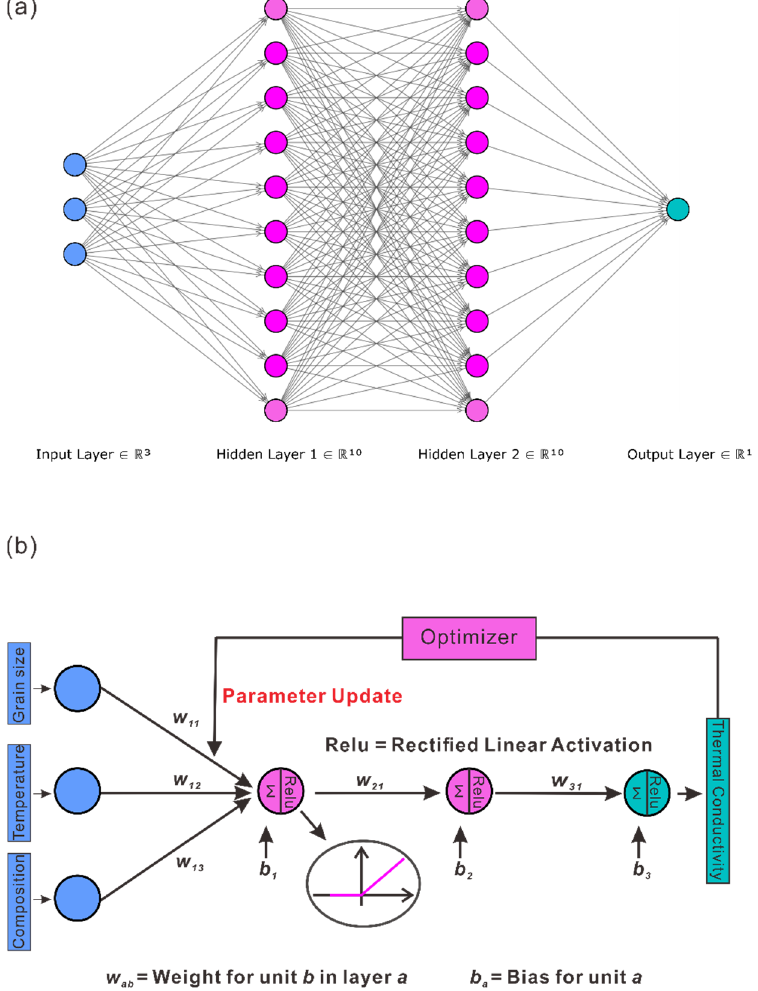
Figure 1. ( a ) The overall structure of the multi-layer DNN; ( b ) The forward propagation and back- propagation of the DNN.